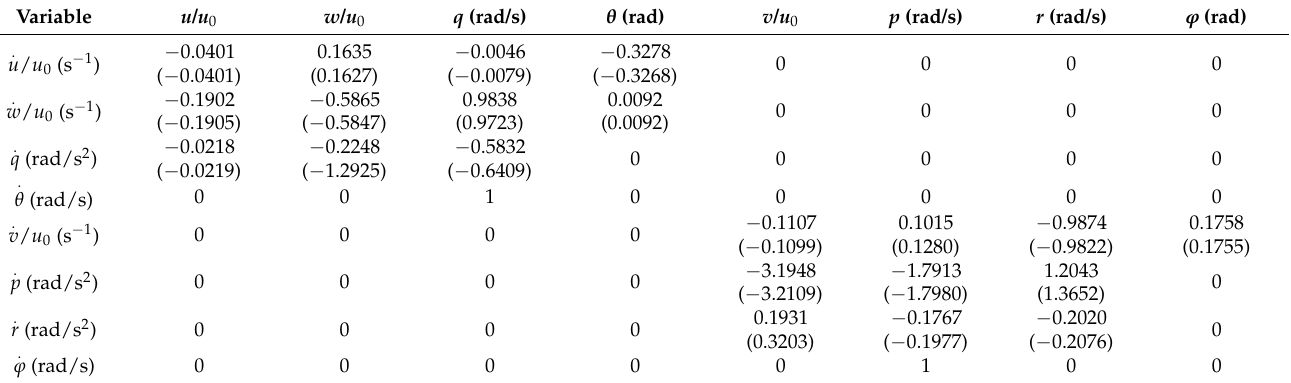
Table 10. CFD–RANS (extrapolated) 8 × 8 stability matrix for flight condition 3 in Tables 4 and